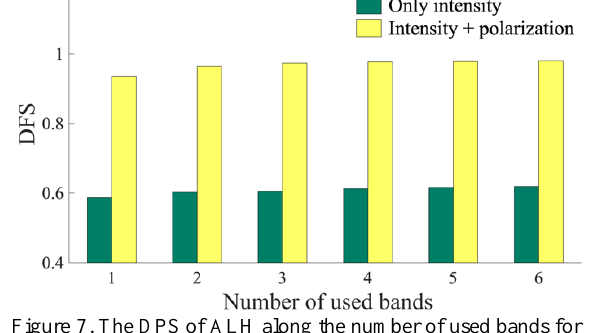
Figure 7. The DPS of ALH along the number of used bands for “only intensity” and “intensity + polarization” multi-viewing measurements.